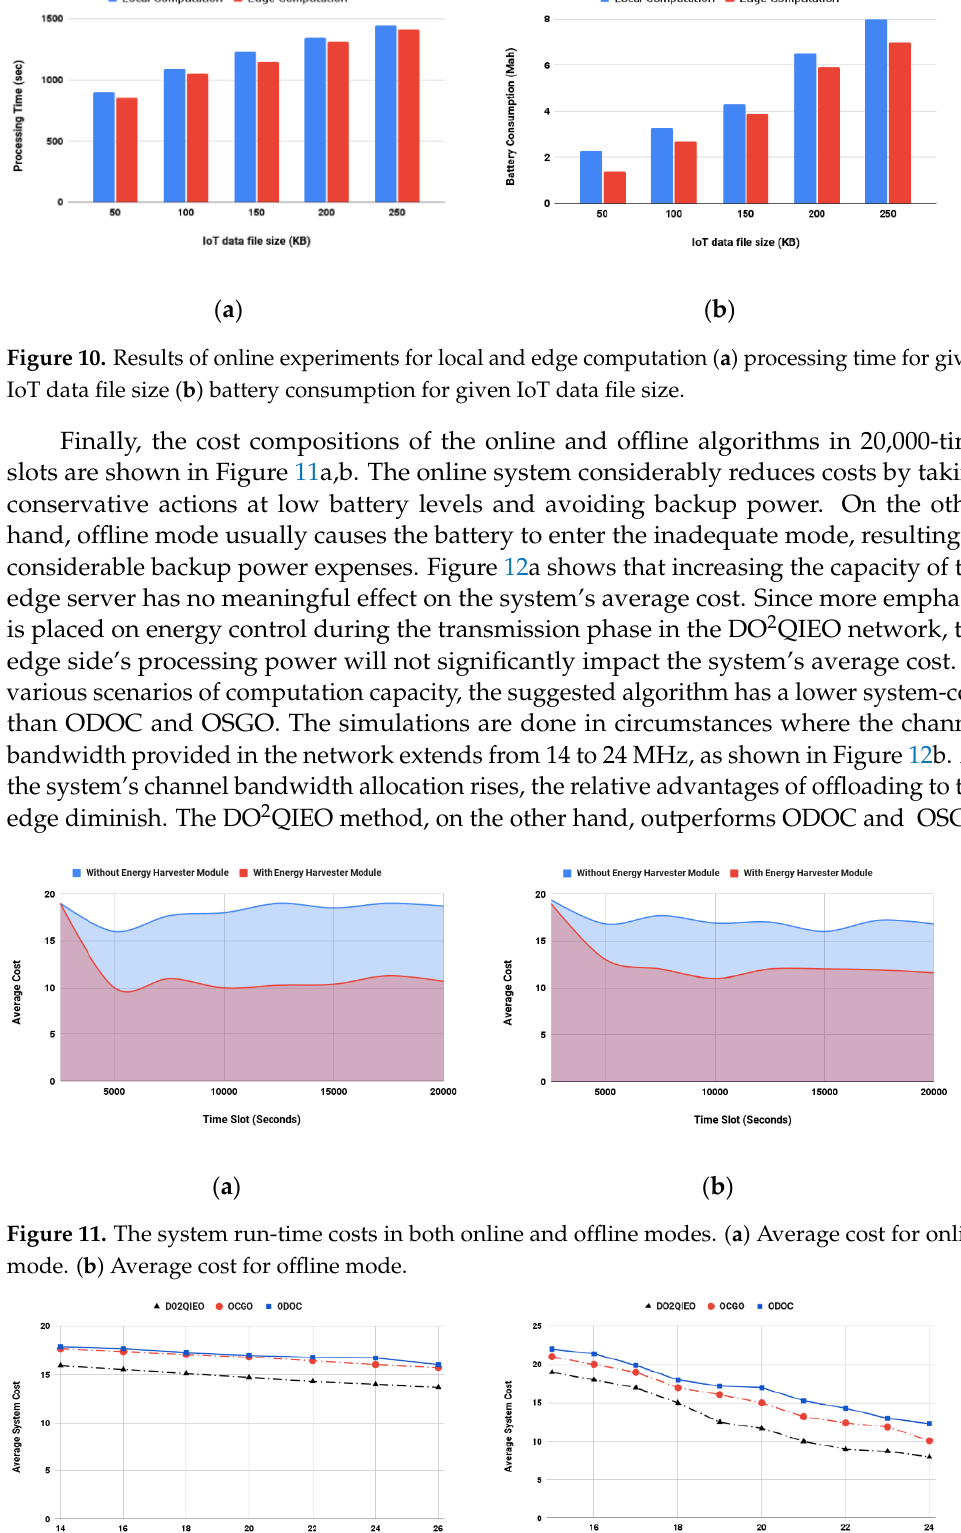
( b ) Figure 9. ( a ) Task failure rate performance with backup energy harvester module. ( b ) The impact of computing task size on total computational overhead in online mode (Figure ( a ) is on the left, Figure ( b ) is on the right ( b )). Additionally, we studied two computing situations to demonstrate the efficiency of the system in online mode, which also included local processing and offloading to the edge for IoT data processing. The IoT data are performed locally in the first case. In the second case, we use our settings to offload IoT data for execution on edge computing. The suggested technique was evaluated using a collection of sensor data files ranging in size from 50 kB to 250 kB. Additionally, every IoT data input is run ten times to generate an average result. As seen in Figure 10, we analyzed the outcomes using two performance metrics: processing time (a) and energy consumption (b). In the situation of task offload- ing to the edge node, the processing time comprises offloading time, execution time, downloading time, and so on. With each IoT data file size, the average processing time of local computation is greater than that of edge computing in Figure 10a. For instance, the offloading system could save up to 38% time when finishing the computation of a 50 kB file and up to 21% time when completing the computation of a 200 kB file, demonstrating the benefits of the offloading method. Because resource-intensive computational pro- cesses are offloaded to the edge, IoT data tasks require less energy when done using the offloading strategy, as shown in the results obtained for battery consumption in Figure